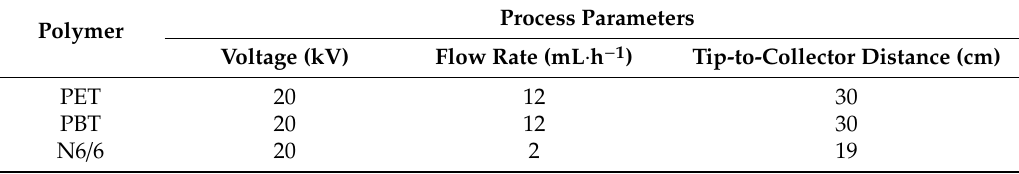
Table 2. Parameters 1 established in the electrospinning process of PET, PBT, and N6 / 6.